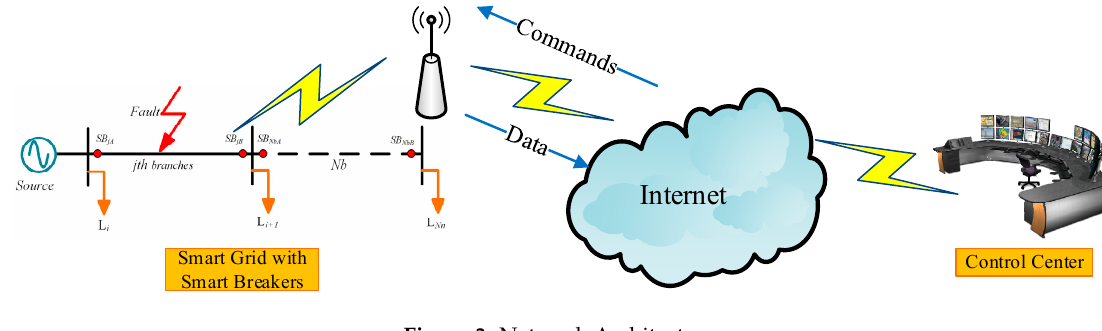
Figure 3. Network Architecture.